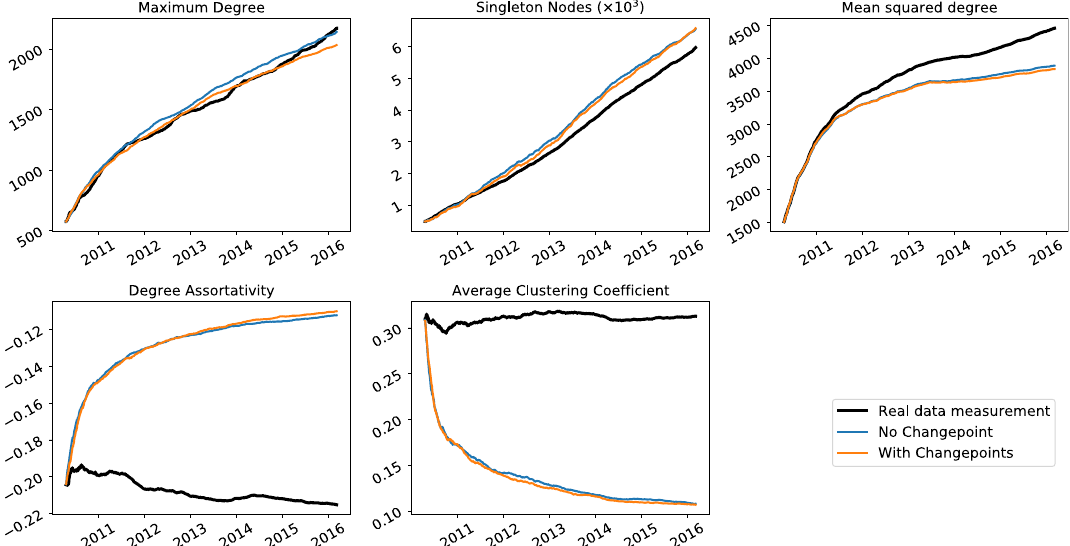
Figure 11. Stack Exchange MathOverflow: comparison on various network statistics between best fitting mixture model without change and its best fitting counterpart fitted over 10 equally sized intervals for the Stack Exchange MathOverflow